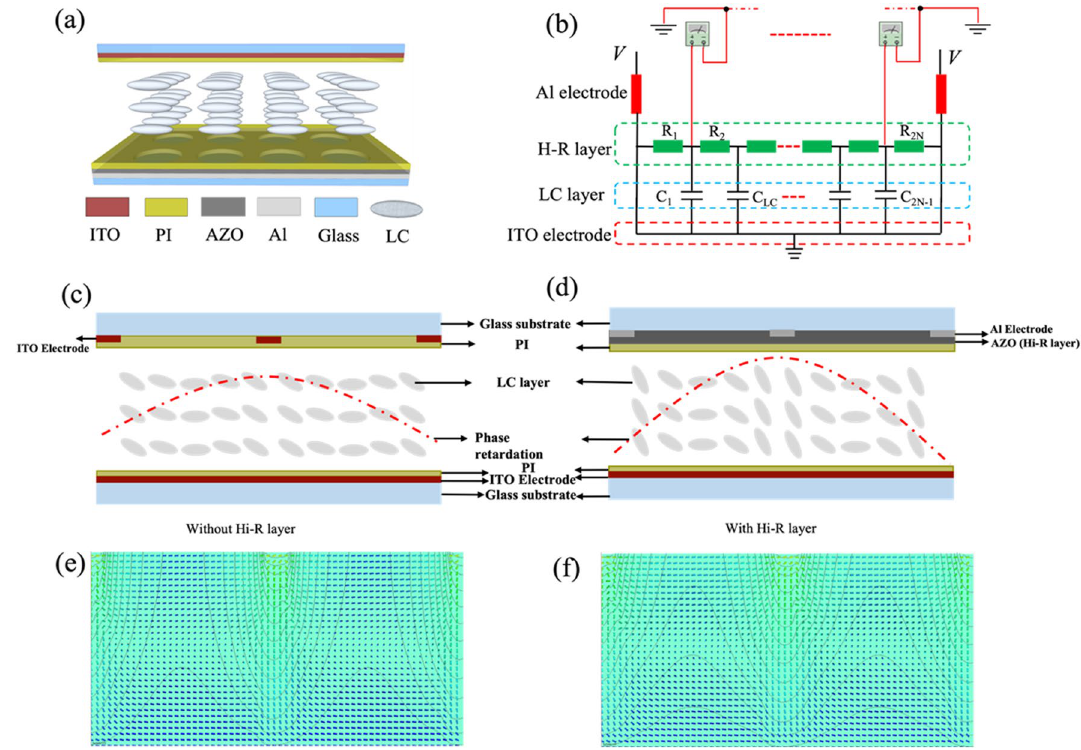
Figure 7. ( a ) Section view of the proposed structure; ( b ) R–C circuit model of the proposed structure; ( c ) schematic diagram of phase retardation of LC MLAs without the Hi-R layer; ( d ) schematic diagram of phase retardation of Hi-R LC MLAs; ( e ) equipotential line and direction distribution of LC MLAs without the Hi-R layer and ( f ) equipotential line and direction distribution of Hi-R LC